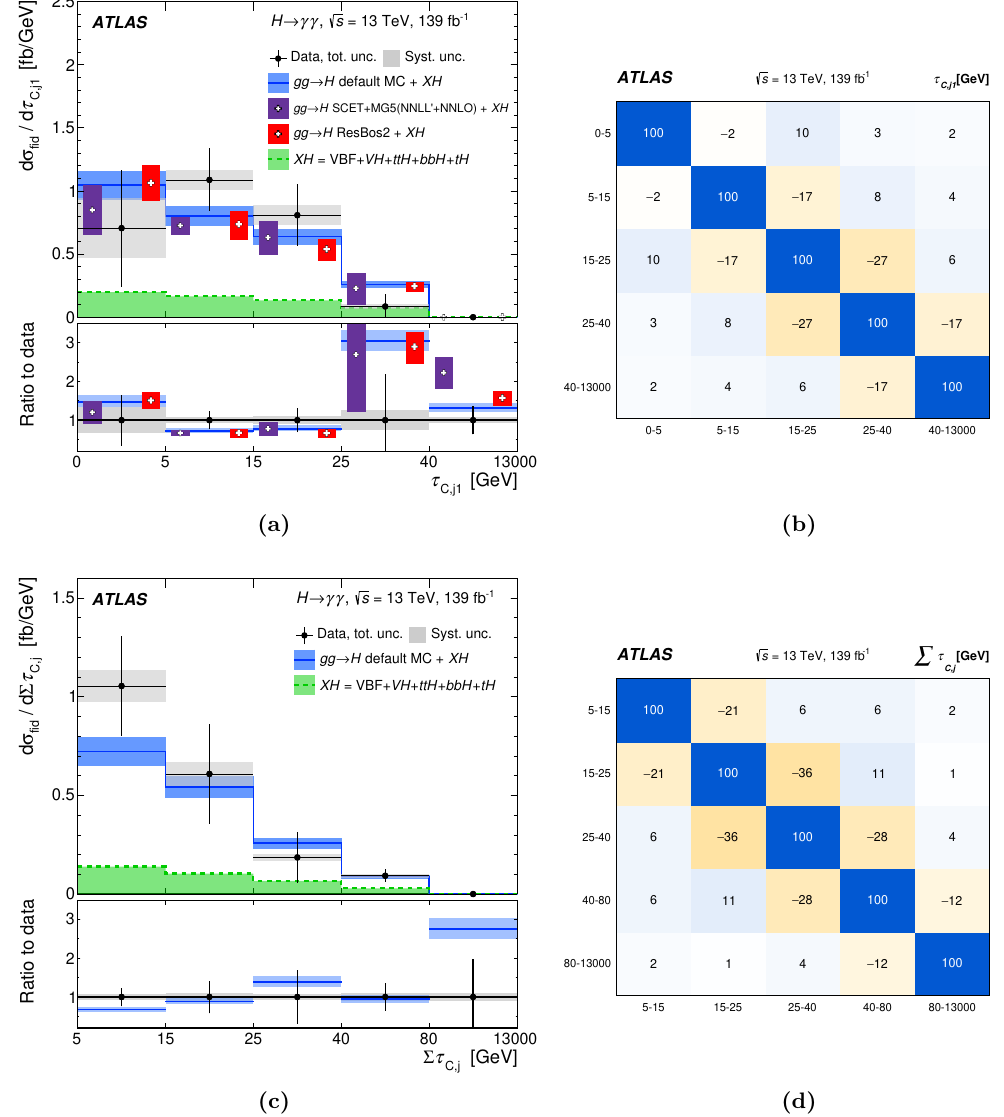
Figure 29. Particle-level fiducial differential cross-sections times branching ratio for the variables: (a) τ and (c) P τ together with the corresponding correlation matrices ((b) and C,j 1 C,j